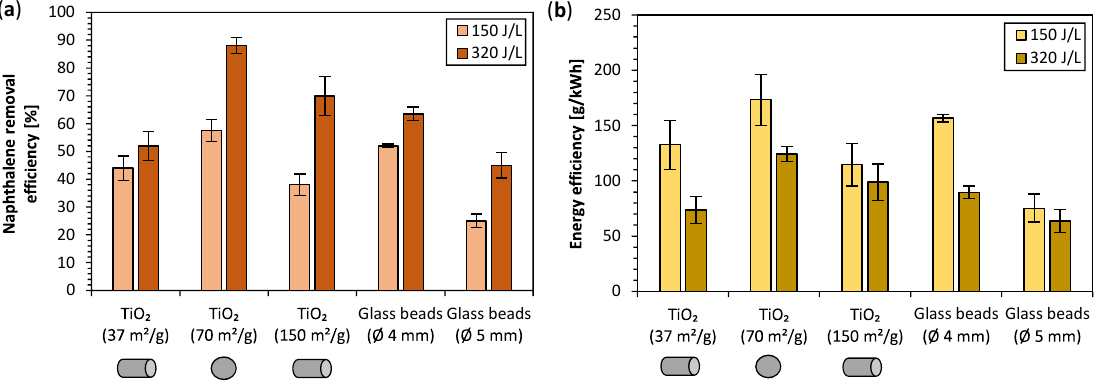
Figure 3. ( a ) Naphthalene removal e ffi ciency and ( b ) energy e ffi ciency for plasma catalytic reactors packed with TiO 2 of various SSAs and shapes and with glass beads of various diameters for the same SIE of 320 J /